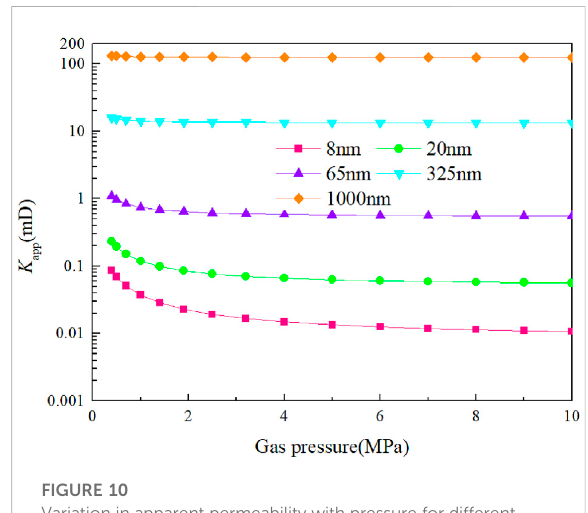
FIGURE 10 Variation in apparent permeability with pressure for different pore